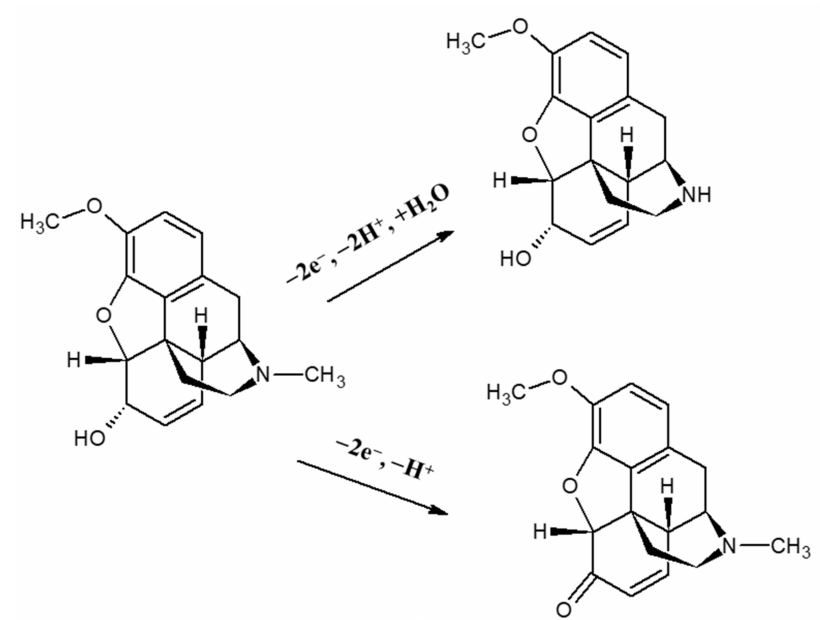
Scheme 1. Proposed mechanism for the electro-oxidation of 3-methylmorphine [26].